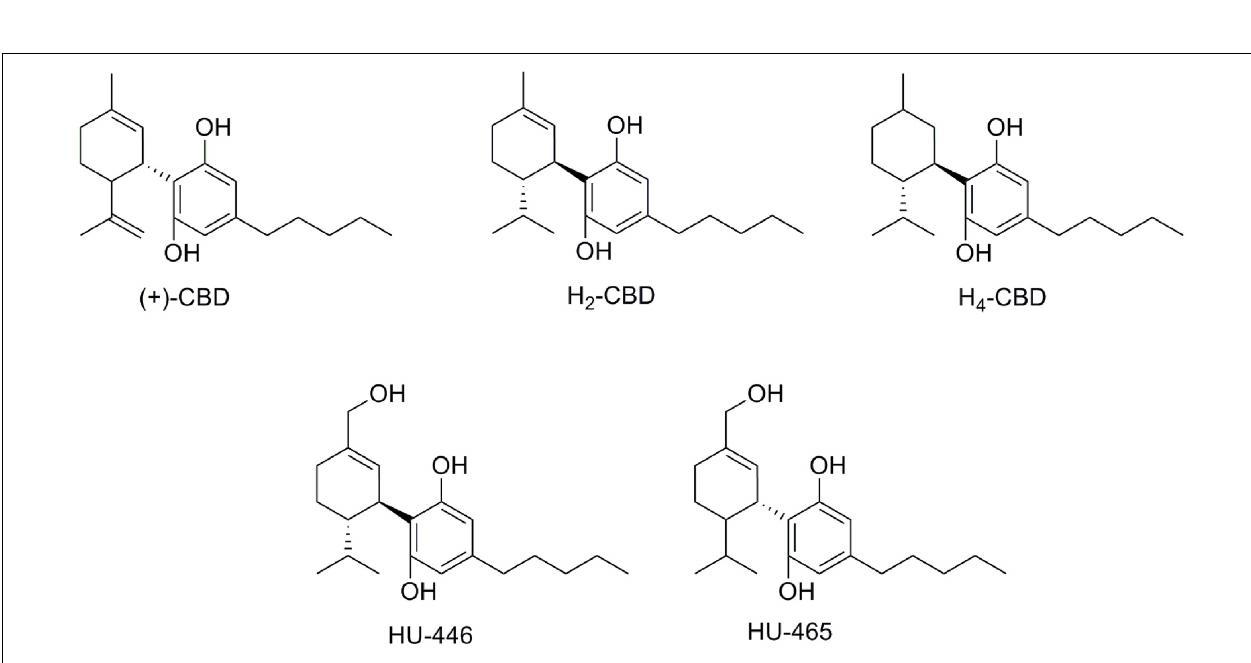
FIGURE 6 | (+)-CBD and hydrogenated CBD